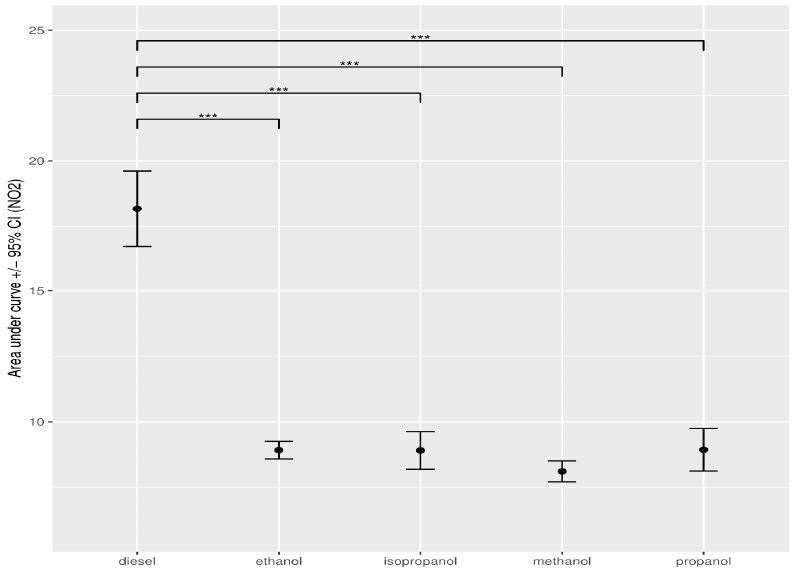
Figure 9. Error analysis bar chart of the concentration of NO 2 , expressed as AUC, measured for the different alcohols between pure and diesel–alcohol mixtures. The dots show the mean AUC value, obtained through bootstrap resampling. Error bars indicate the 95% confidence interval around the mean. Asterisks show the significance of the pairwise comparison of the AUC values (*** p < 0.001).